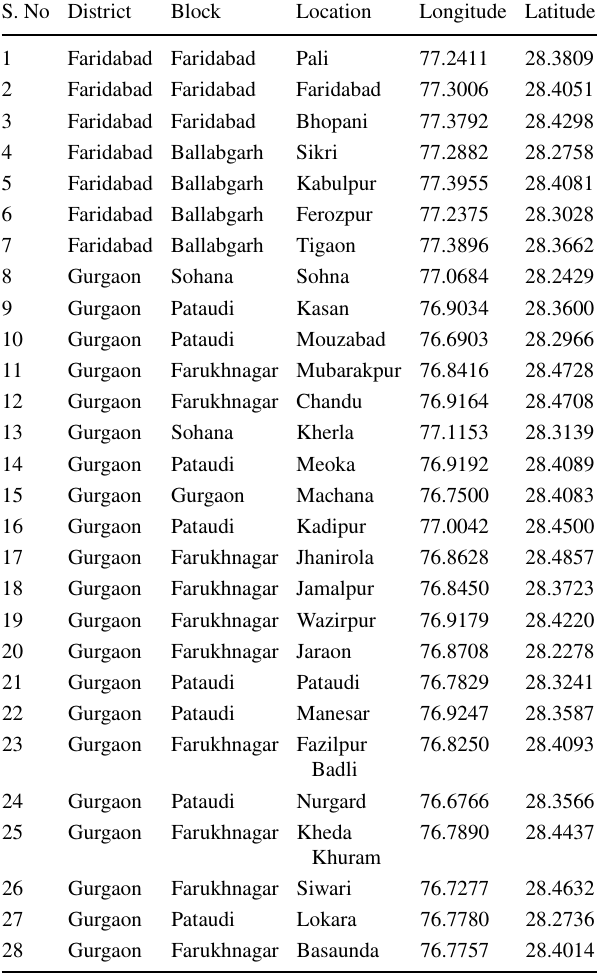
Table 1 Location details of the sites for groundwater quality investi- gation